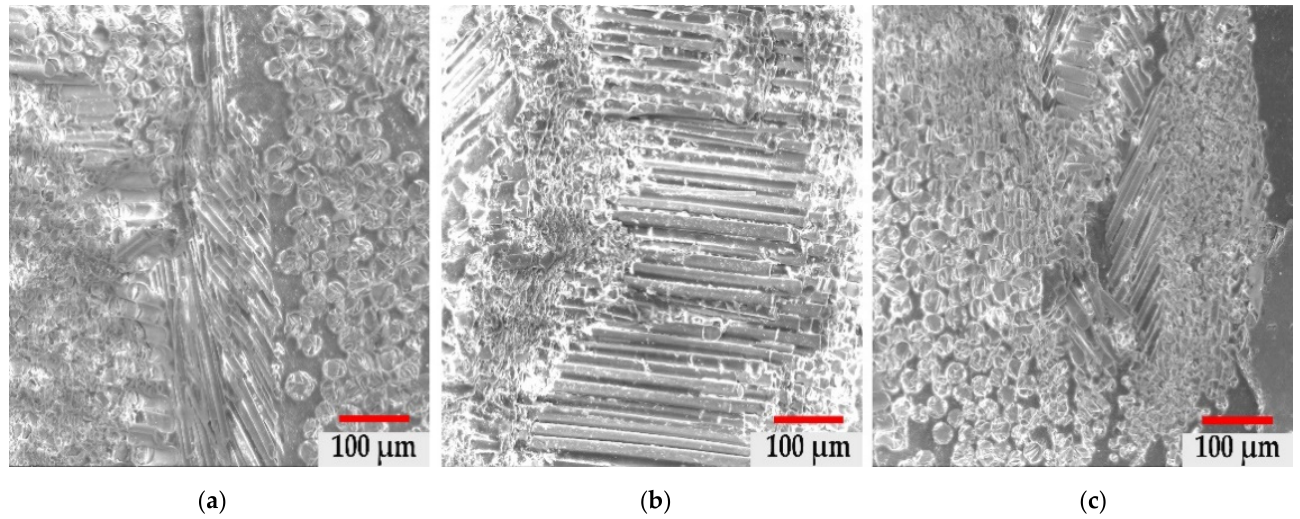
Figure 6. Morphological structure of the outer layer: ( a ) neutral soil, ( b ) basic soil, ( c ) acidic soil. Figure 6 confirms the continuity of the fibres in the structure of the pipes used in a neutral environment, having a parallel and substantially equal fibre structure in different areas of the material and with different orientations, without a preferential orientation.